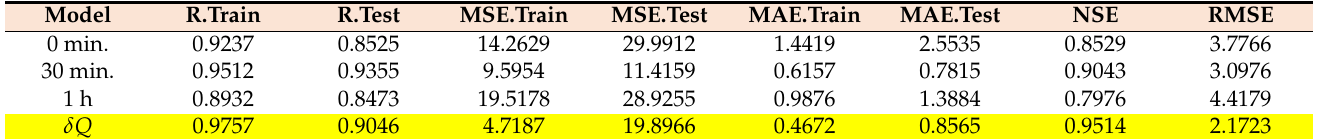
Table 3. Performance of LSTM with bat algorithm models for streamflow.